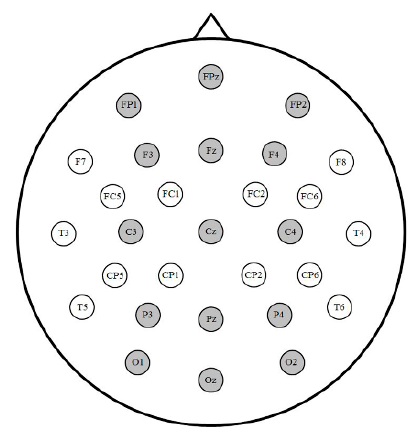
Figure 2. Electrode montage with gray channels included in event-related potential (ERP) analyses. Fifteen analyzed channels were distributed across five levels of Anterior/Posterior (Prefrontal, Frontal, Central, Parietal, Occipital) and three levels of Laterality (Left, Midline,